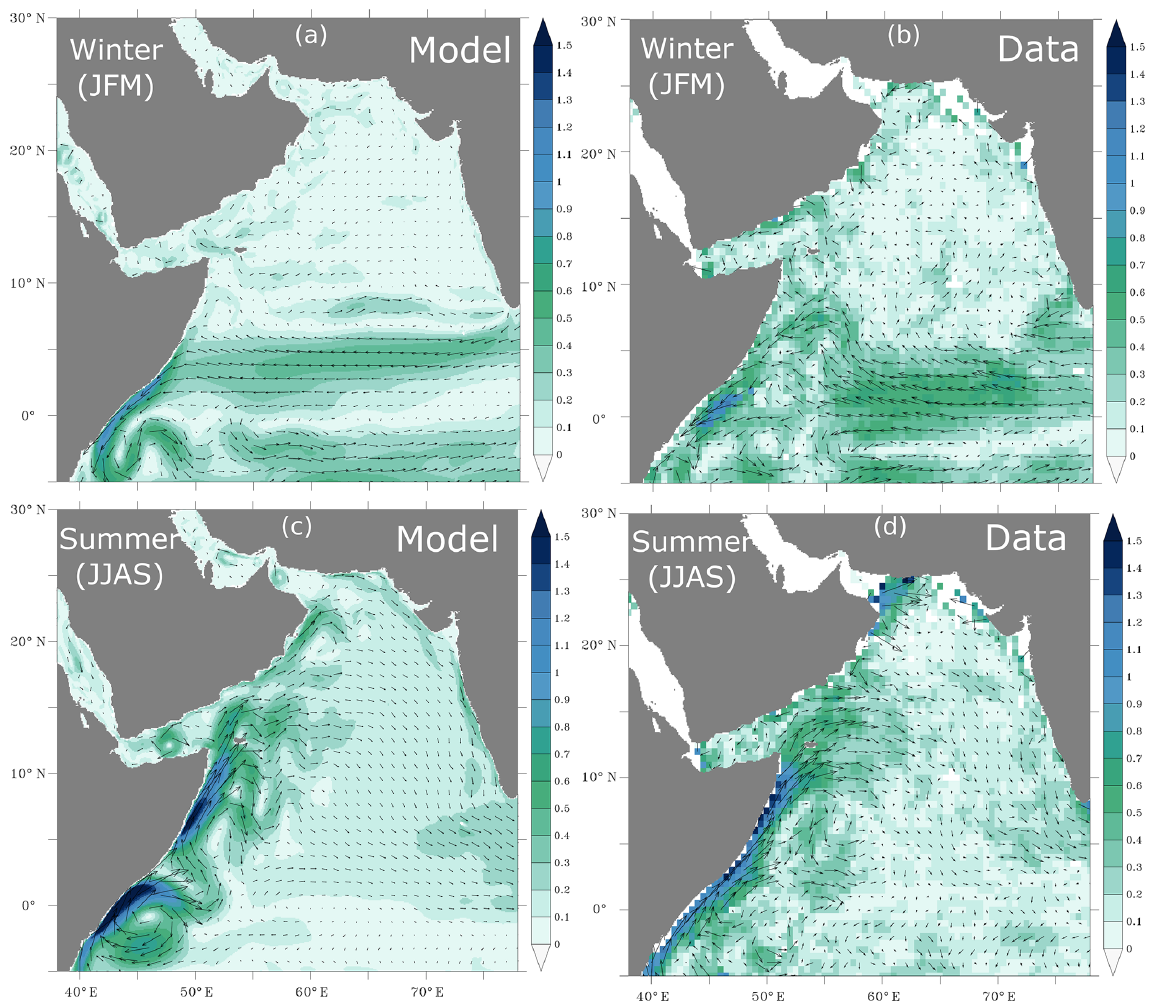
Figure A1. Surface circulation. Surface circulation as simulated in the model (a, c) and from surface drifter climatology of Lumpkin and Johnson (2013) (b, d) in winter (a, b) and summer (c, d) months. Arrows indicate the direction of the current and the color shading shows the current magnitude (in ms − 1